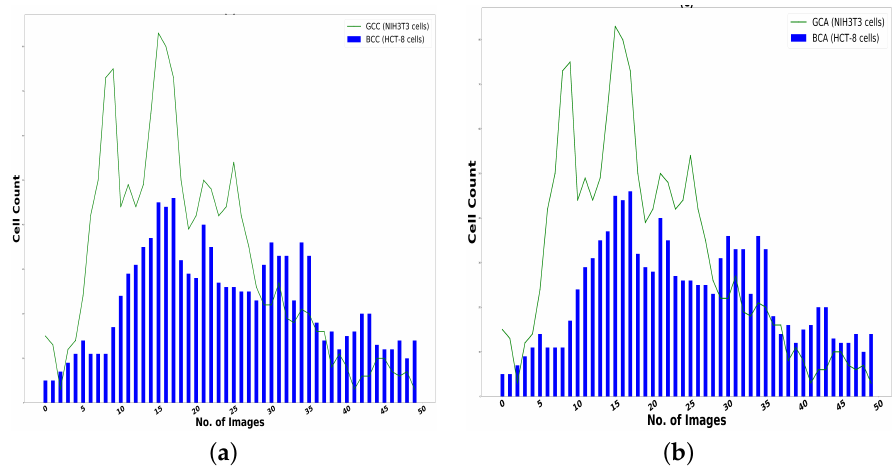
Figure 9. ( a ) Blue cell count (BCC) and green cell count (GCC) plots. ( b ) Blue cell area (BCA) and green cell area (GCA) from periphery to core of in vitro 3D cell spheroid of 2:0.5 ratio slices.